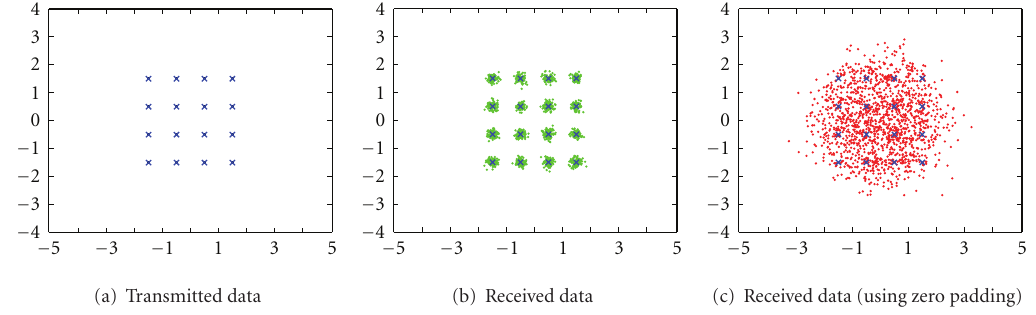
Figure 2: QAM-16 bit errors occurring due to transmission and decoding.